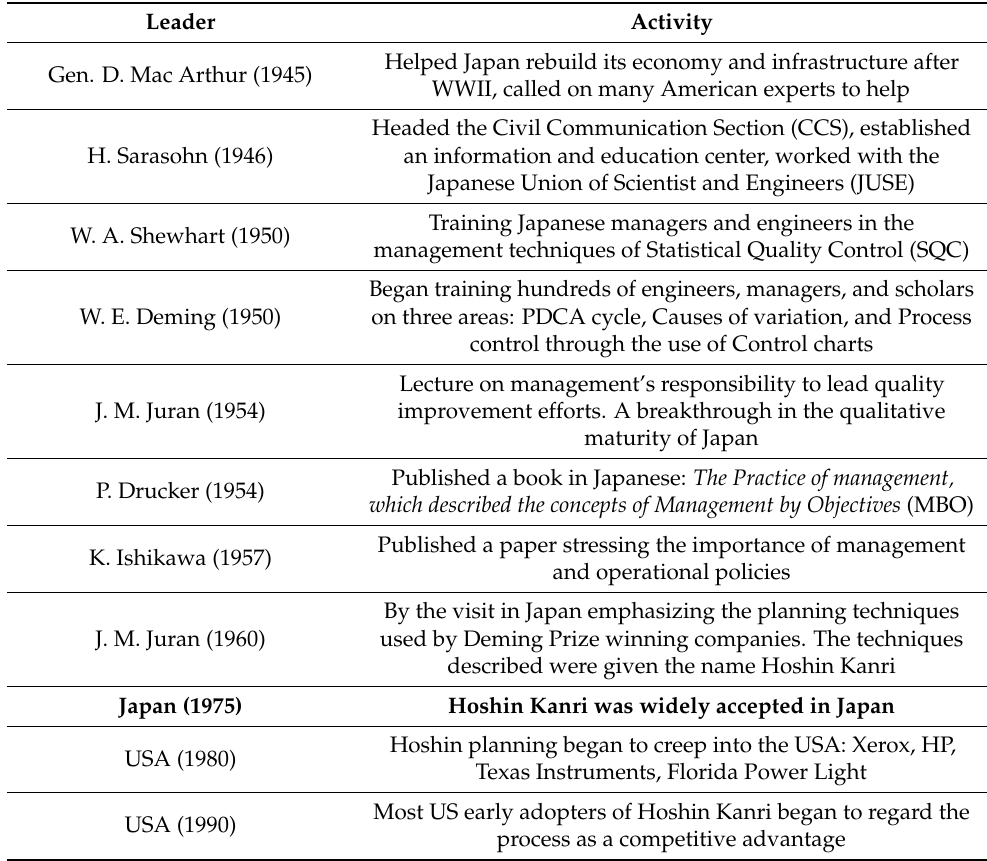
Table 1. History and background of Hoshin